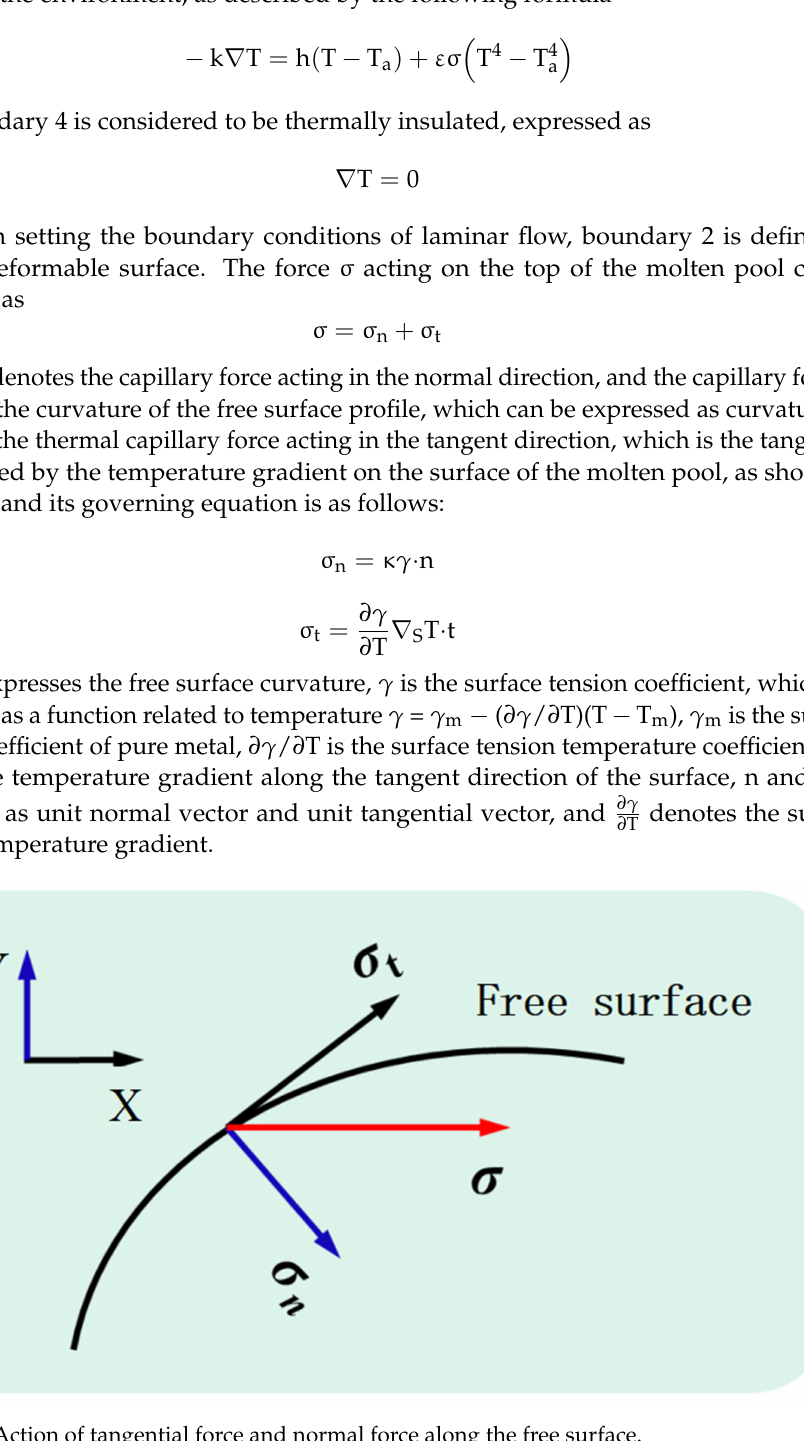
Figure 10. Action of tangential force and normal force along the free